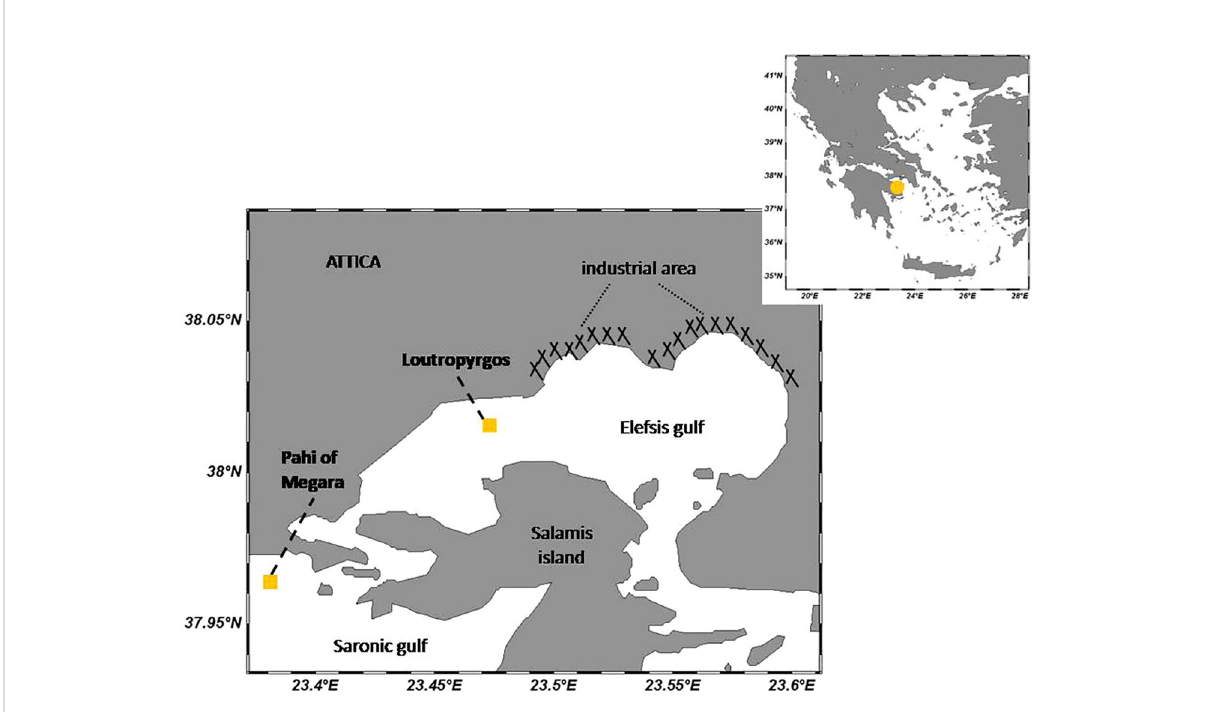
FIGURE 1 Coastal sampling sites (Schlitzer, Reiner, Ocean Data View, odv.awi.de,